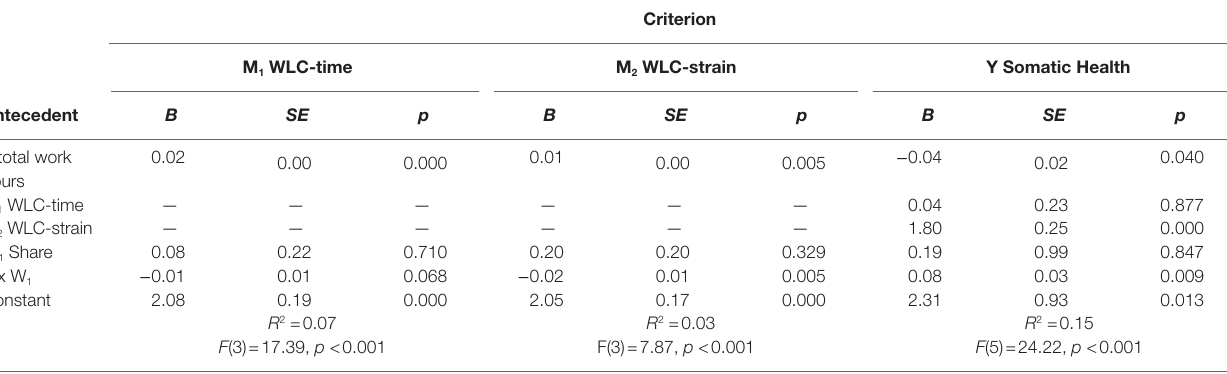
TABLE 5 | Moderated mediation analyses for the effect of total work hours on somatic health, mediated by work-life conflict, and moderated by share of CW in total work hours.